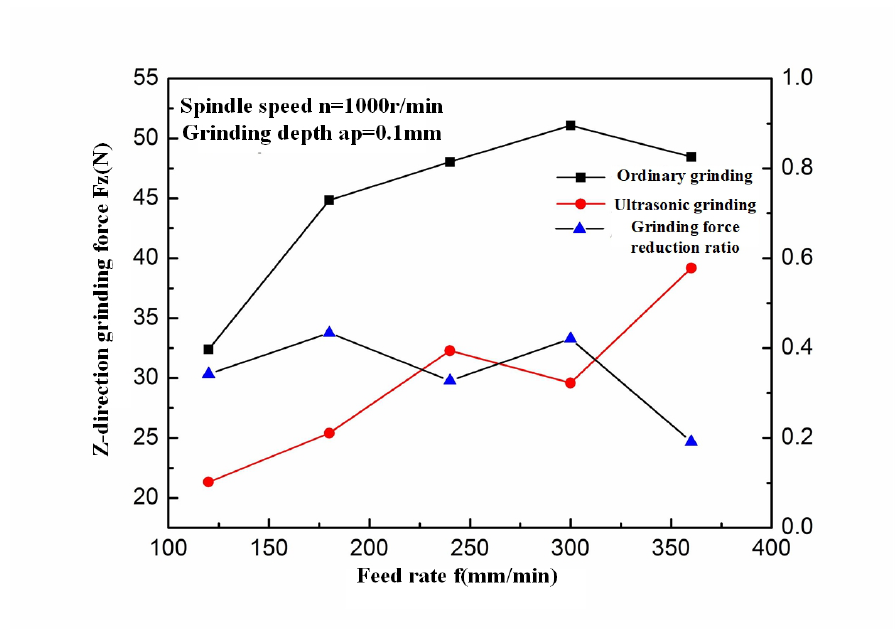
Figure 15. Comparison of ultrasonic grinding and ordinary grinding force at different feed speeds.